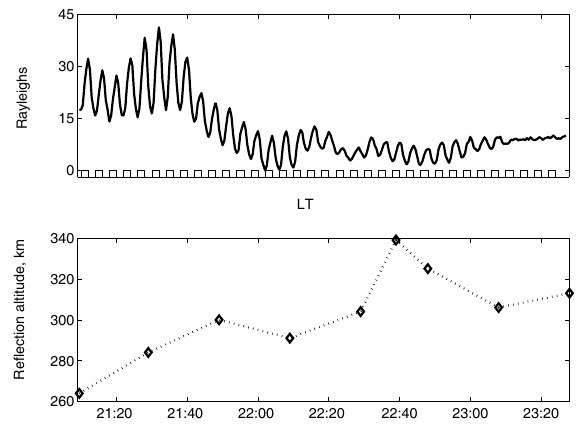
Fig. 1. The average intensity of the 630-nm airglow above the back- ground (top panel). The bars show the pump wave on/off cycle. The Figure 1 for the paper by Grach et al. “On the location and structure…” bottom panel shows the reflection altitudes of the O -polarized pump wave at 4.3MHz vs. time during the experiment as determined from the